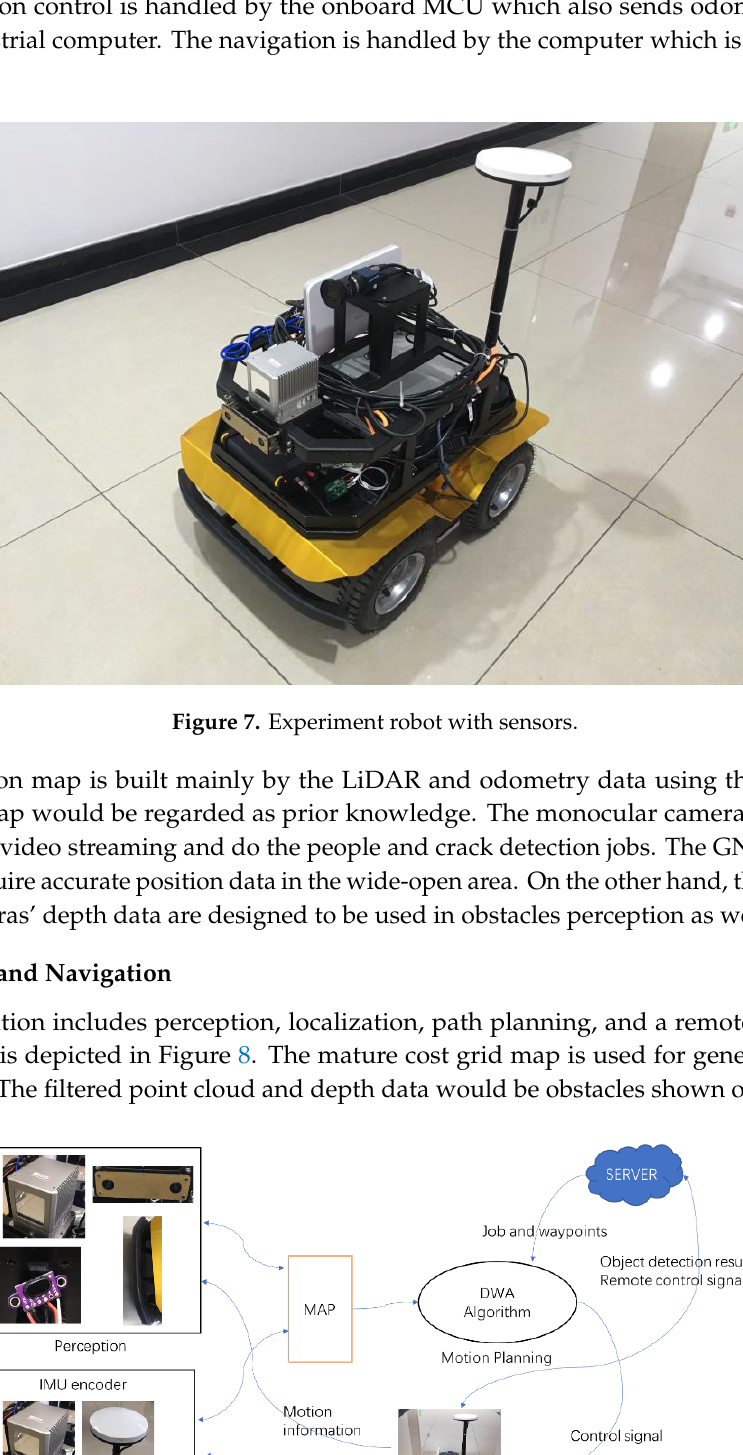
Figure 7. Experiment robot with sensors.